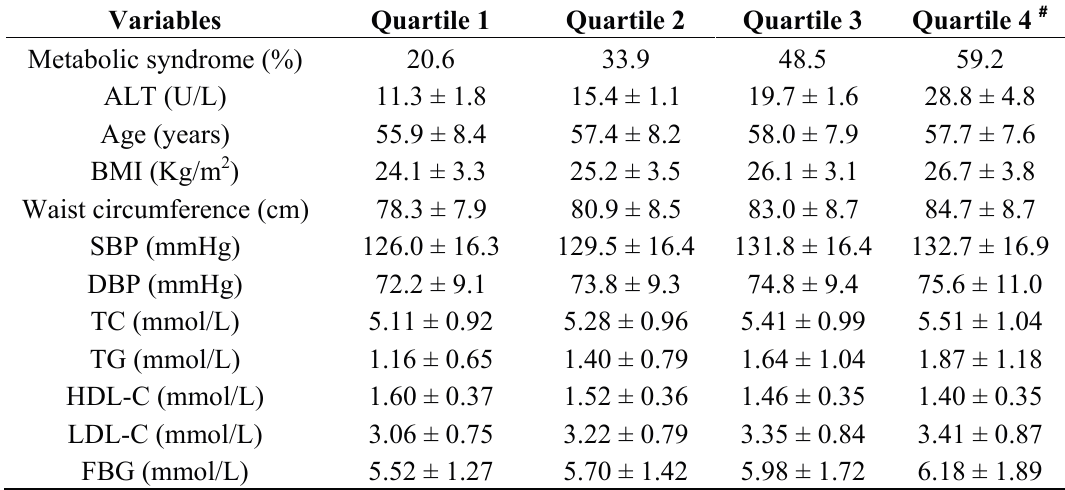
Table 3. Characteristics of participants stratified by ALT quartiles in females.